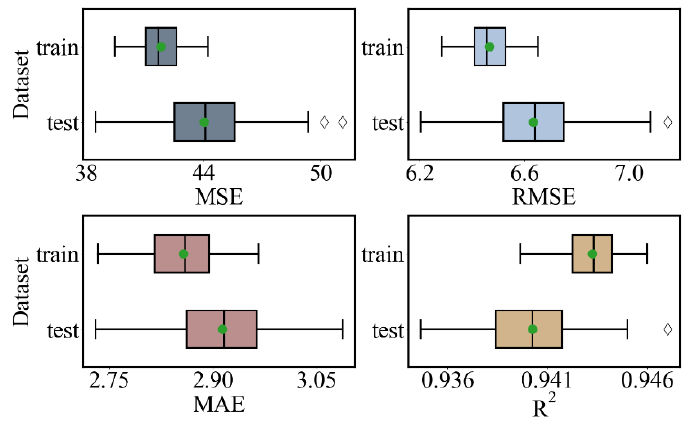
Figure 5. Evaluation results of the initialized XGB.